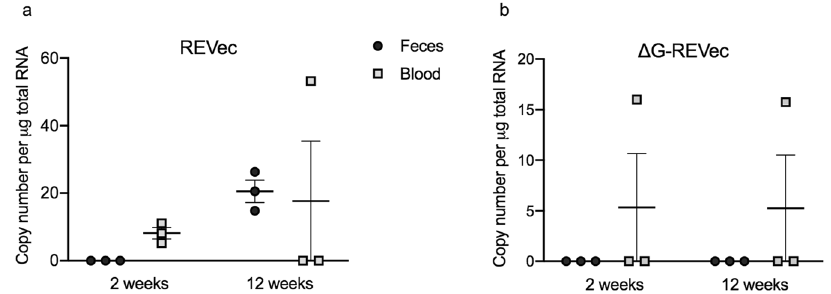
Figure 6. Vector shedding analysis. Vector copy number in feces and blood were determined by RT-qPCR at 2 and 12 weeks post-administration with ( a ) REVec-GFP or ( b ) Δ G-REVec-GFP (n =